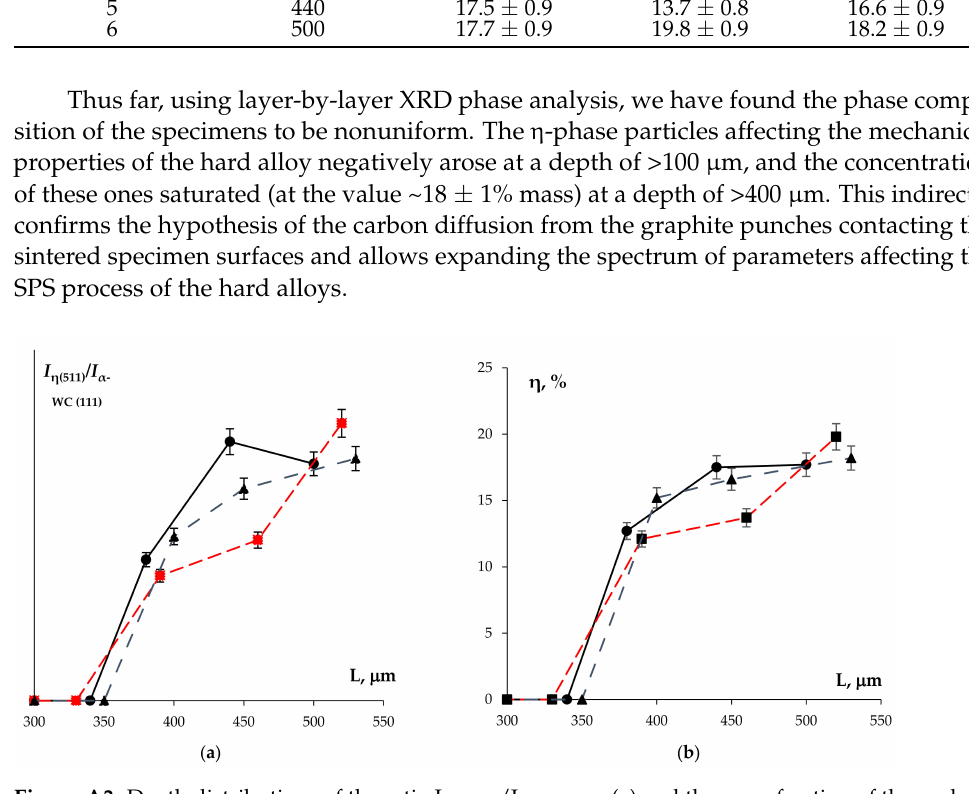
Figure A3. Depth distributions of the ratio I η (511) /I α -WC (111) ( a ) and the mass fraction of the η -phase particles ( b ) in the WC-10% Co hard alloy specimens: line (1)—without degassing; lines (2) and (3)—the specimens sintered with degassing at 850 ◦ C for 10